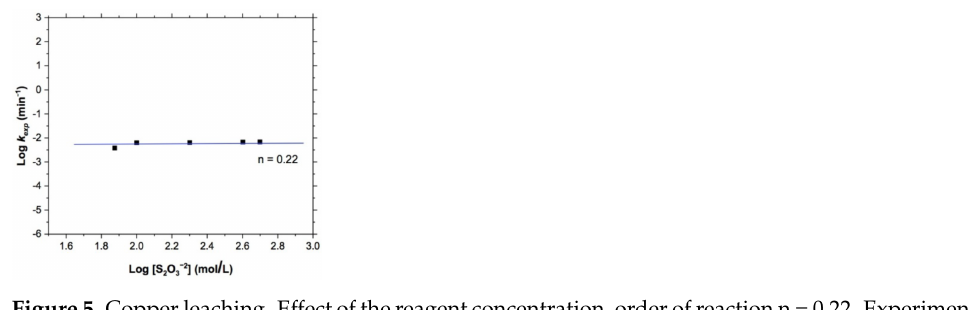
Figure 5. Copper leaching. Effect of the reagent concentration, order of reaction n = 0.22. Experimental conditions: 318 K, pH 10, 750 RPM, and 1 atm O 2 .